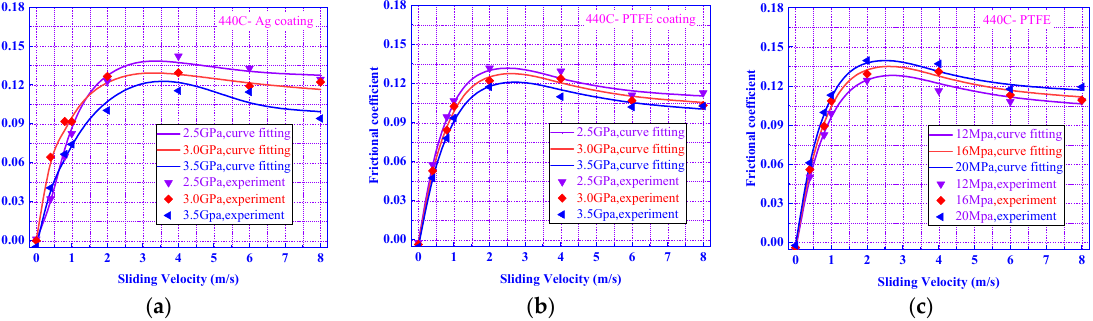
Figure 4. The comparisons between the computation results and the experimental data. ( a ) 440C-Ag